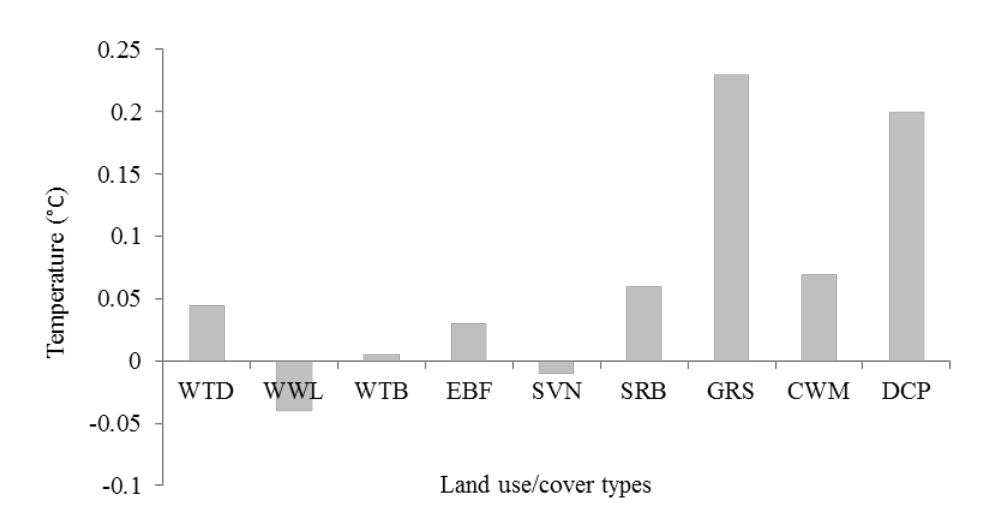
Figure 7. The difference of temperature (°C) of different land covers in Brazilian Amazon in